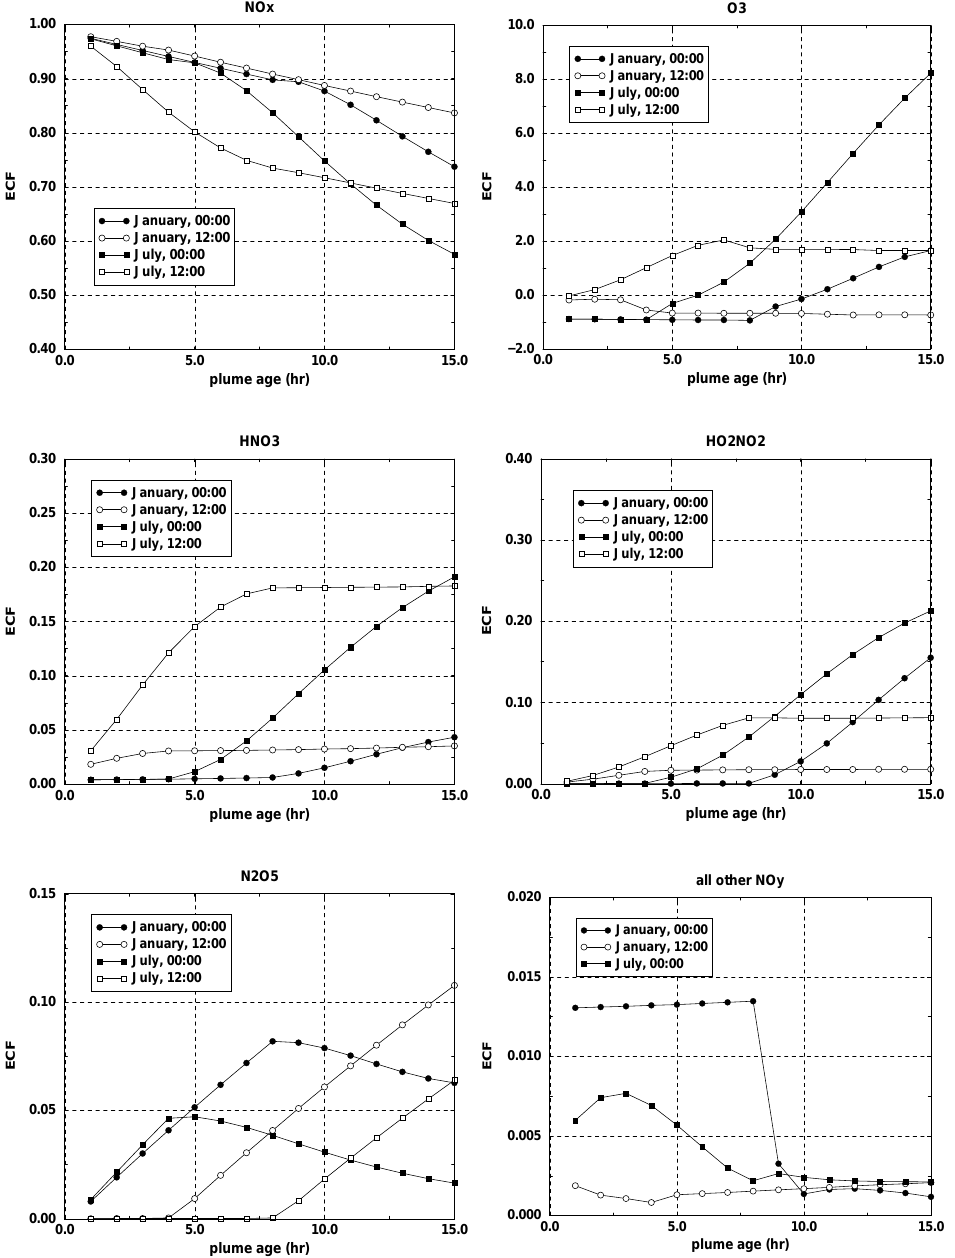
Fig. 13. Time series of emission conversion factors for some key species at different emission times (Meijer, 2001). 5 Integration of emission parameterizations into global